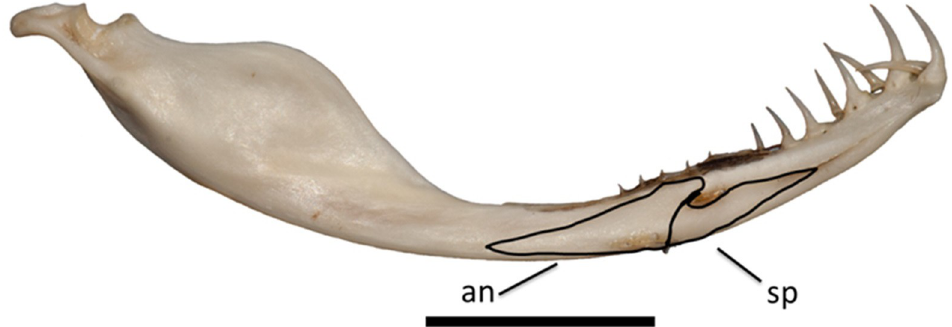
Fig 3. Lower left jaw of Tropidolaemus wagleri (APPSU 25797) in medial view. Anterior is to the right. Scale bar = 10 mm. Abbreviations: an = angular; sp =